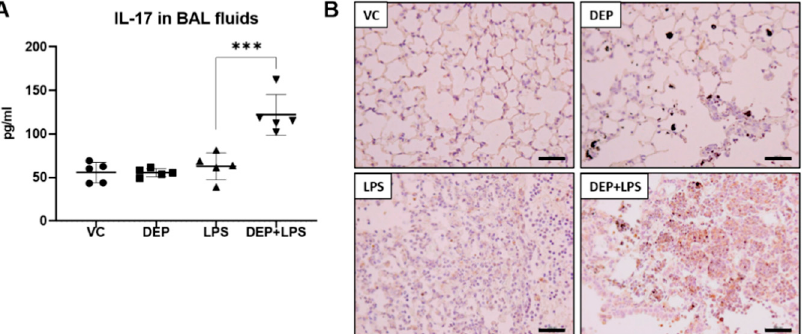
Figure 6. Protein levels of ( A ) IL-17 in the bronchoalveolar (BAL) fluid and ( B ) representative images of immunohistochemistry (IHC) for IL-17 (brown color) in the lung tissue sections from mice in the VC, DEP, LPS, and DEP pre-exposed and LPS-instilled (DEP+LPS) groups. Scale bars = 200 nm. Data represent means ± SD (n = 5 per group) *** p < 0.001 vs. LPS group.